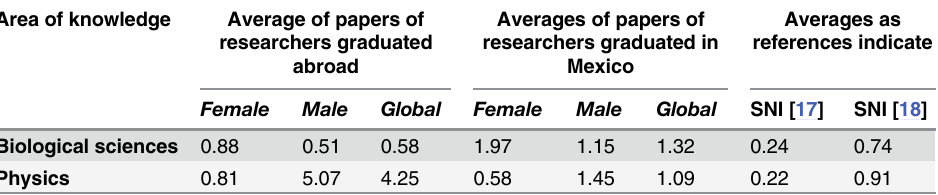
Table 12. Distribution of the average number of papers per author/year in Biology and Physics. Area of knowledge